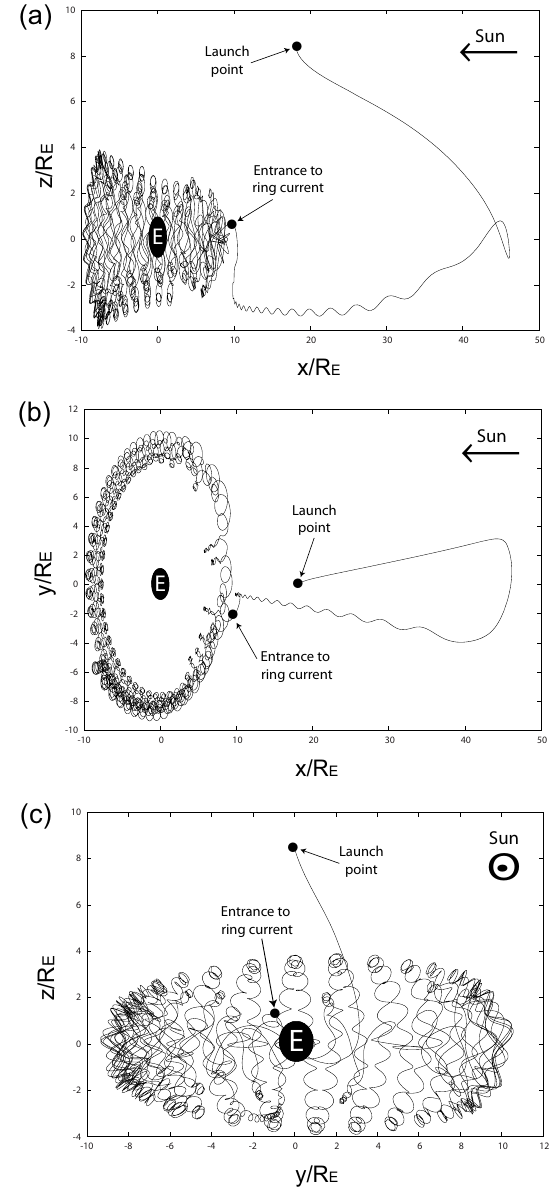
Figure 6. Projections of a trapped O + ion orbit with initial conditions t 0 = − 8min, r(t 0 ) = 20 R E , φ(t 0 ) = 24h, θ(t 0 ) = 25 ◦ , α(t 0 ) = π/ 2, E k (t 0 ) = 4keV, moving until t 1 = 3h during a distur- bance with t g = 30min, t r = 35min, Kp (t i ) = 1, and Kp (t g ) = 5.